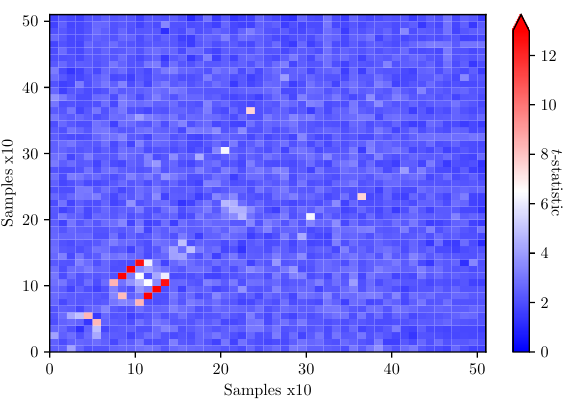
Figure 5: Bivariate second-order t -test for the two-share version with 10 000 traces. The t -statistic shows the absolute